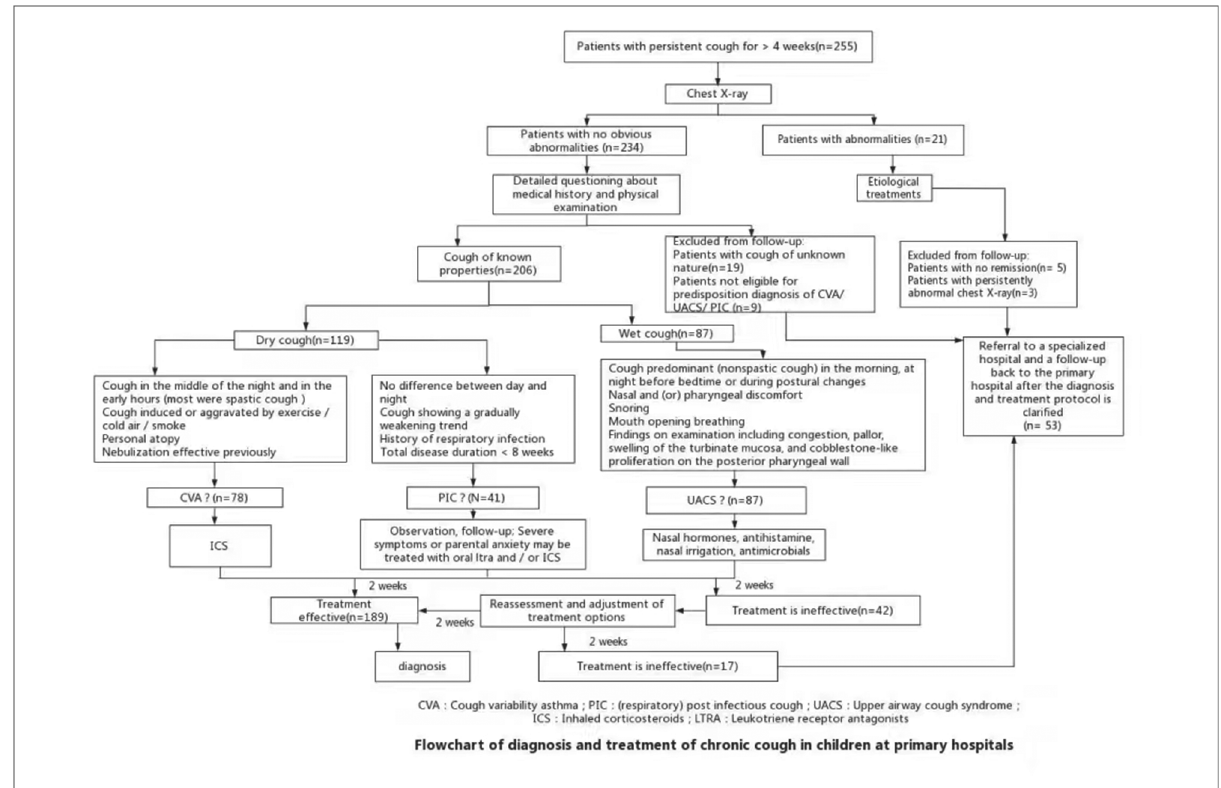
FIGURE 2 Flowchart of the diagnosis and treatment of chronic cough in children at primary hospitals.